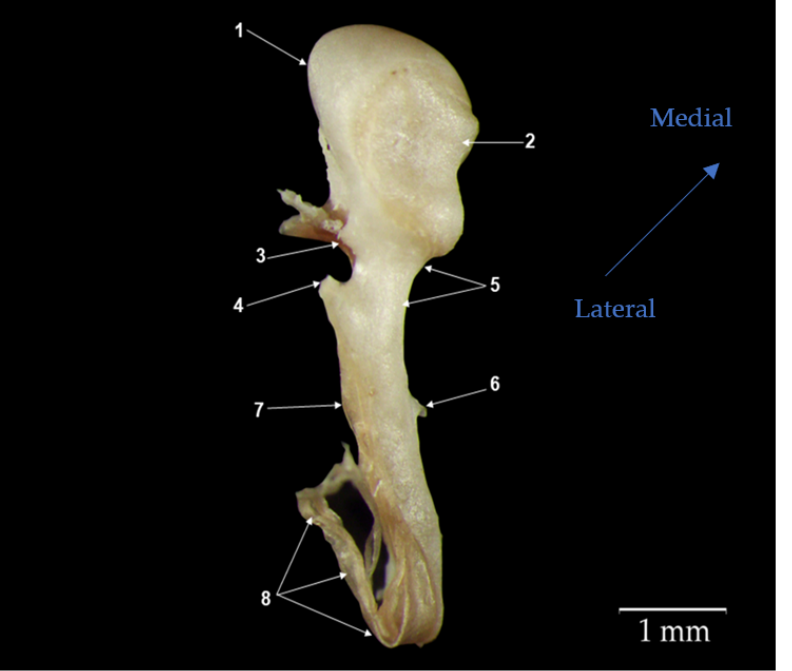
Figure 1. Anatomical features of malleus. (1) Head of malleus ( Caput mallei ); (2) articular surface ( Facies articularis) ; (3) anterior process ( Processus rostralis ); (4) lateral process ( Processus lateralis ); (5) neck of malleus ( Collum mallei ); (6) muscular process ( Processus muscularis ); (7) handle of malleus ( Manubrium mallei) ; (8) tympanic membrane fragments ( Membrana tympani ).